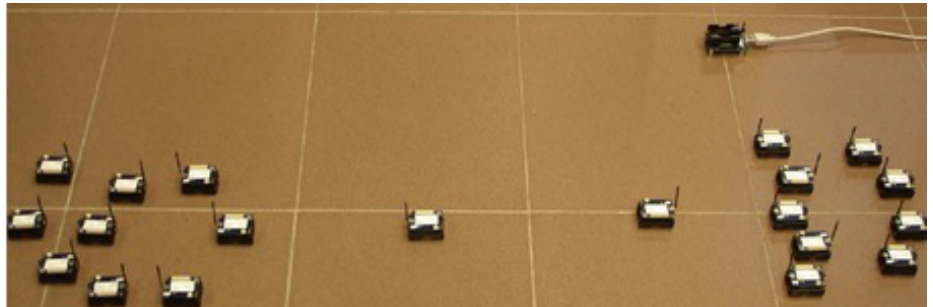
Figure 9. The deployment of the dense